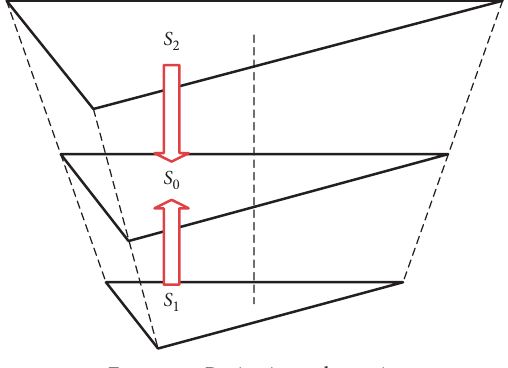
Figure 7: Projection